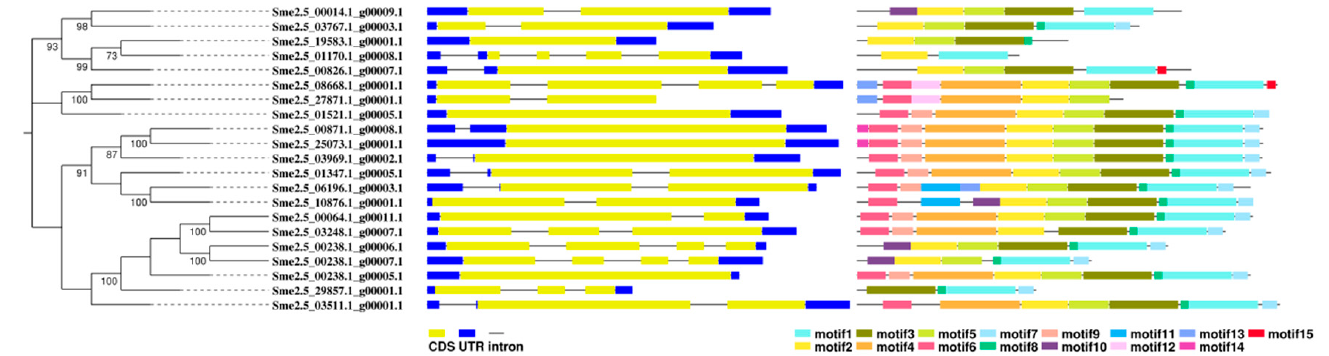
Figure 10. The intron–exon structure and conserved motifs of eggplant SmKCS genes according to their phylogenetic relationships. Lengths of introns, exons, and motifs of each SmKCS gene are shown as proportions.